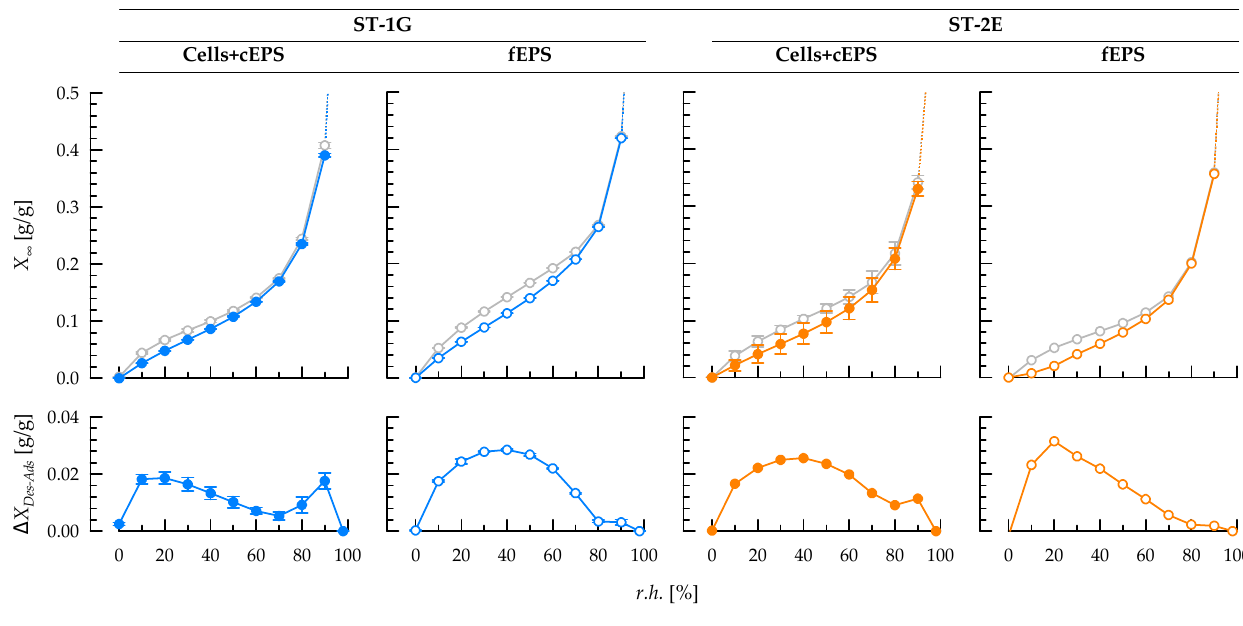
Figure 3. Top: Adsorption (color) and desorption (grey) isotherms of fEPS (open symbols) and cell isolates with attached cEPS (closed symbols) from S. thermophilus ST-1G (blue) and ST-2E (orange). Bottom: Difference between desorption and adsorption isotherms. r.h. : relative humidity; X ∞ : equilibrium moisture load; X Des-Ads : difference in moisture load between desorption and adsorption. Table 4. Moisture load at r.h. = 90% (X 90 ), hysteresis area between adsorption and desorption iso- therms and Guggenheim–Anderson–De Boer (GAB) equation parameters X 0 , k GAB and C GAB for ad- sorption and desorption.